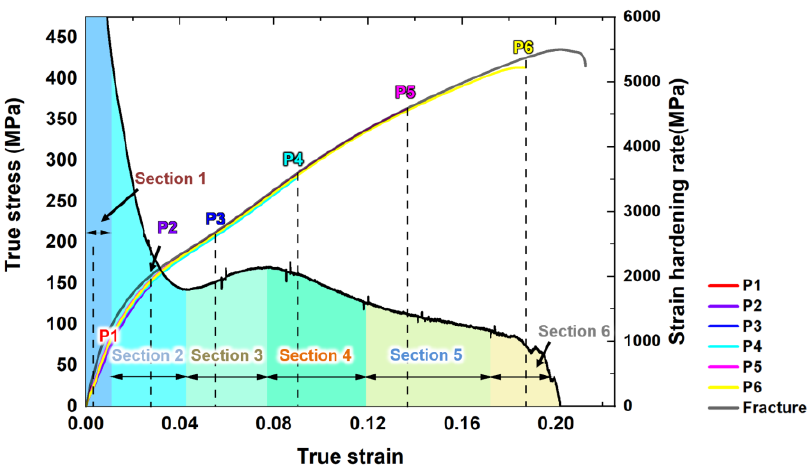
Table 2. The six compression strain points for further microstructure characterization.